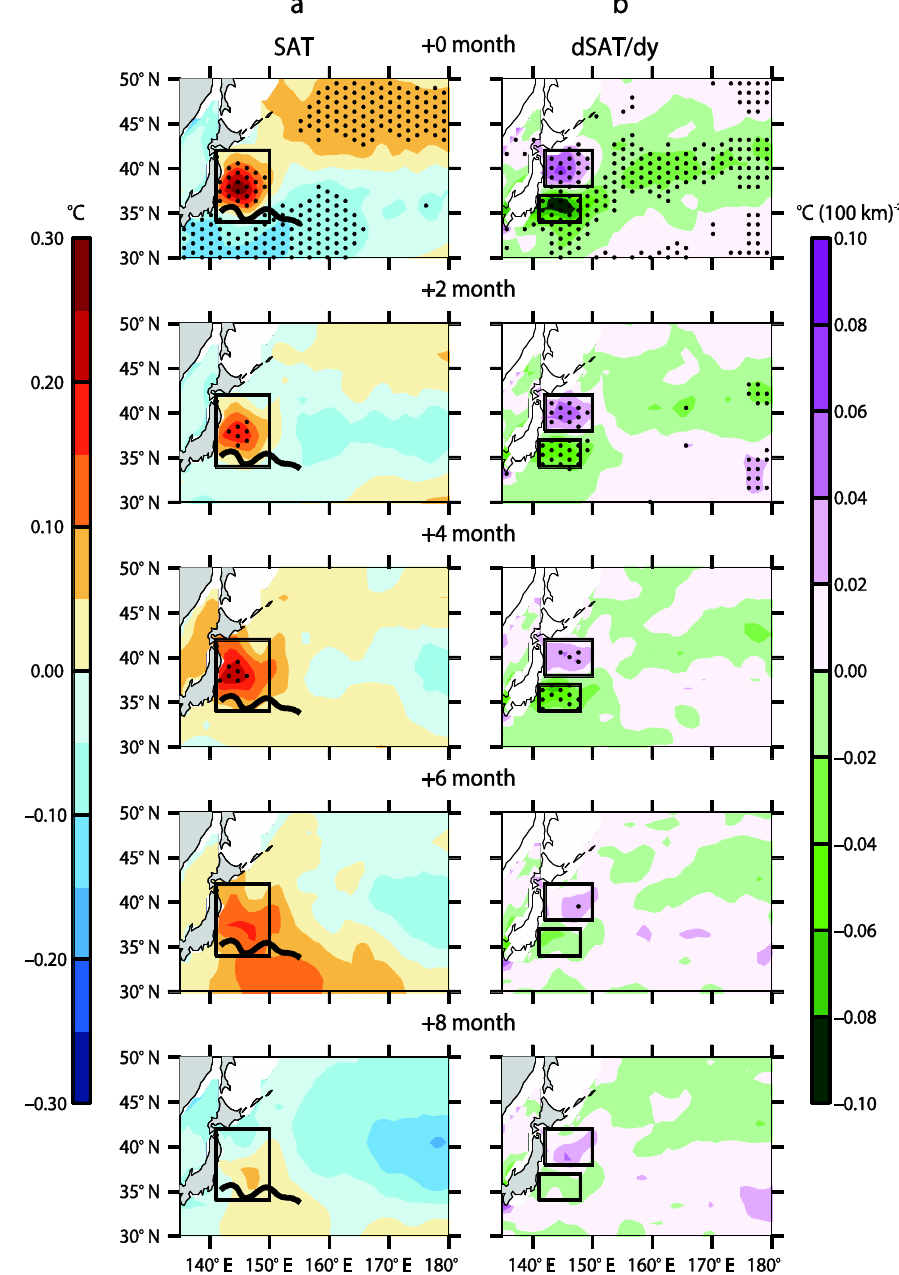
Figure 6. Same as in Figure 5, but for the ( a ) SAT and ( b ) its meridional-gradient (dSAT / dy) anomalies. The black box and the thick black line in (a) denote the KOCR and mean KE jet axis, respectively. The black boxes in (b) indicate the regions used to define the BDI (see text for details).